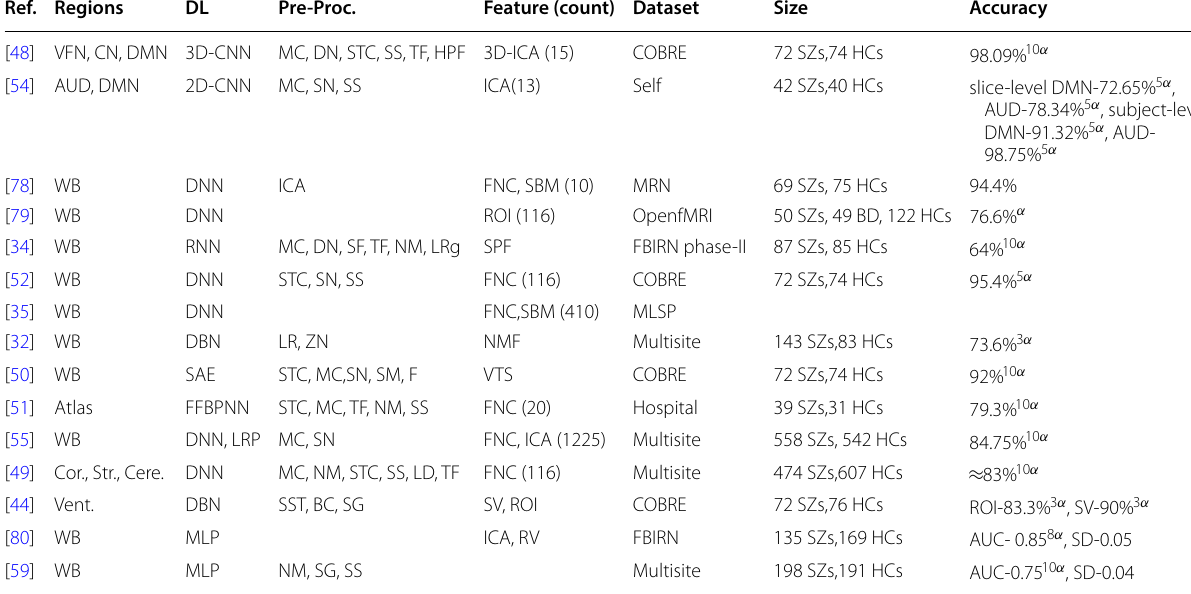
WB whole brain, Cor. cortical, Str. striatal, Cere cerebellar, Vent. ventricle, MRN mild research network, VFN visual frontal network, AUD auditory cortex, CN cerebellar network, DMN default mode network, n α = n-fold cross-validation, SPF spatial feature, NMF neuro-morphometric features, VTS voxel time series, SV segmented ventricle, Self self-generated dataset